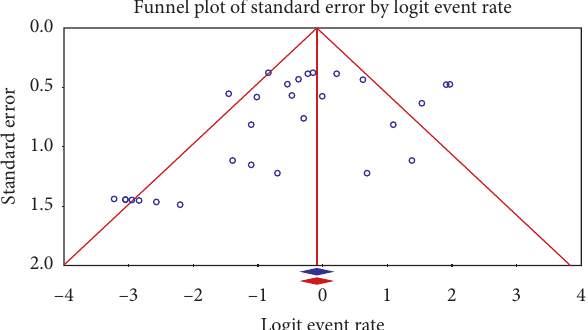
Figure 5: Forest plot of the meta-analysis of the prevalence of C. coli resistant to ciprofloxacin in